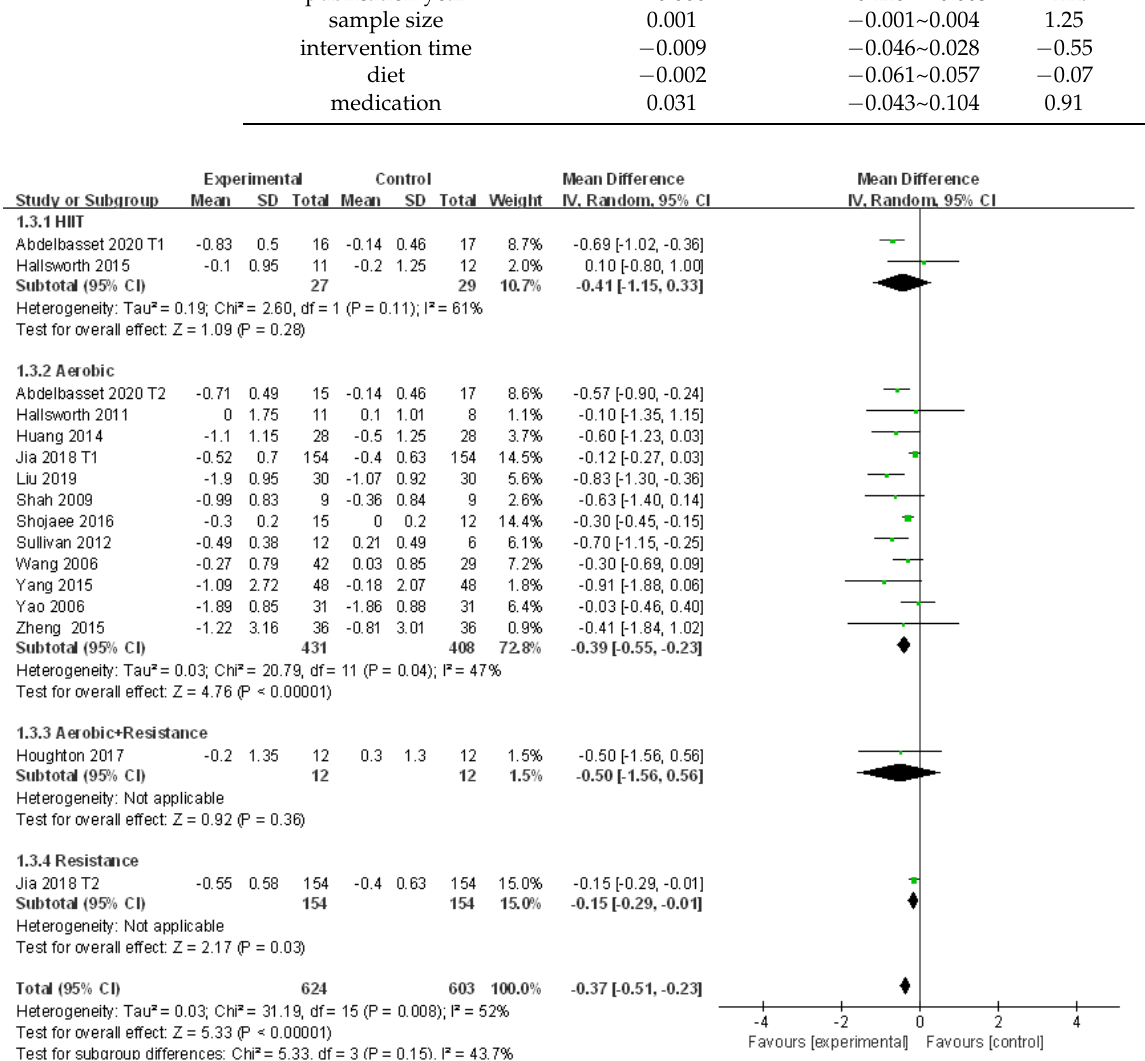
Figure 4. Subgroup analysis of different exercise styles on total cholesterol (TC).